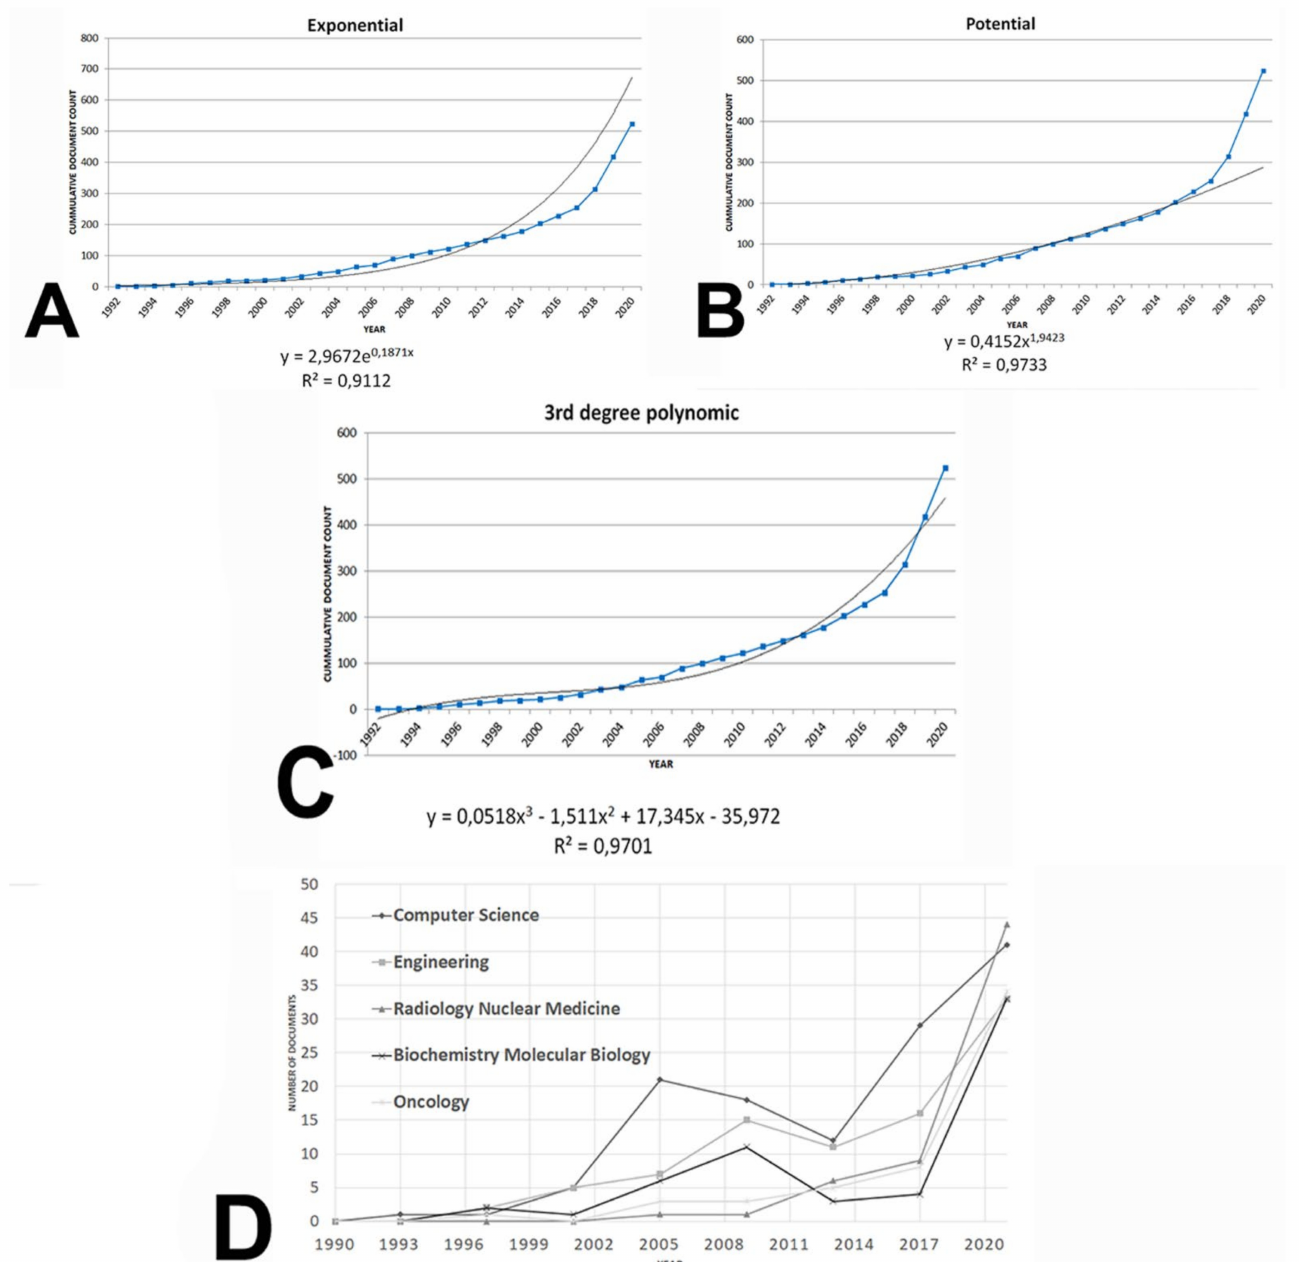
Figure 2. Cumulative journal production by year in the area of AI and ML applications to diagnostic pathology in lymphoid neoplasms. ( A ) Adjustment to an exponential model. ( B ) Adjustment to a potential model. ( C ) Adjustment to a third degree polynomic model. ( D ) Evolution of the five most developed research areas in terms of article production (computer science, engineering, radiology nuclear medicine, biochemistry molecular biology, and oncology) from 1990 to